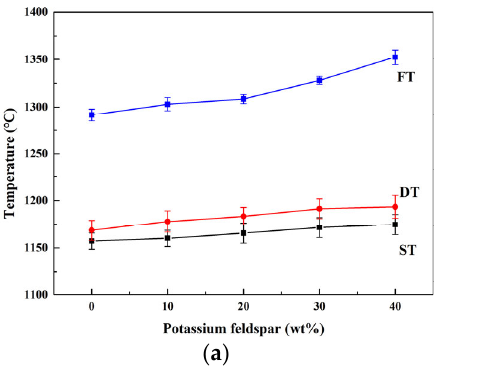
Figure 13. ( a ) Fusibility characteristic temperature, and ( b ) bulk density and water absorption of samples with different potassium feldspar contents at 1200 ◦ C for 20 min.